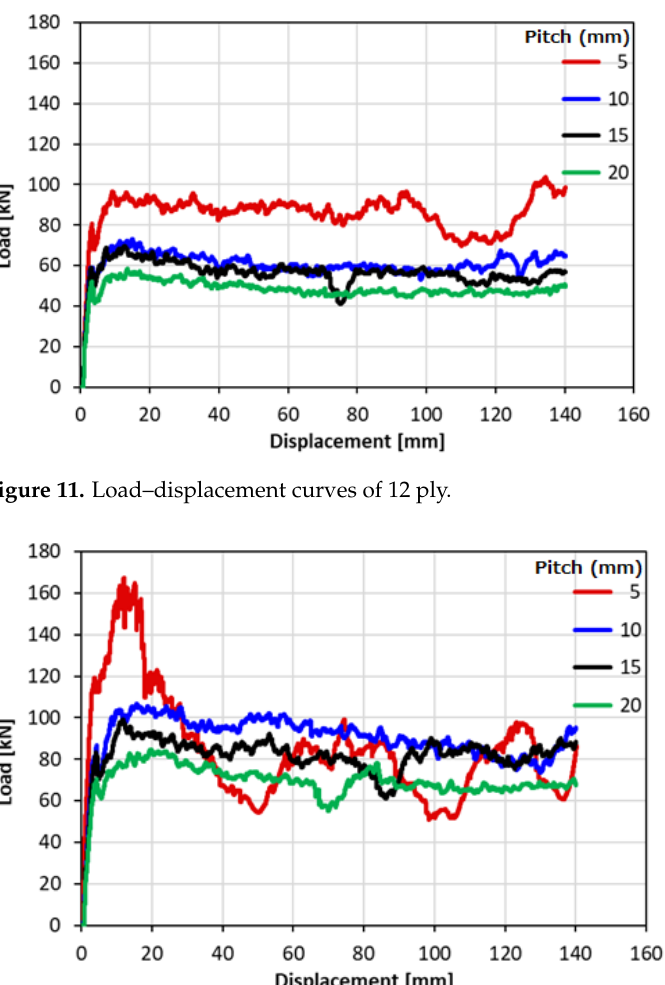
Figure 10. Load–displacement curves of 8 ply. Figure 10. Load – displacement curves of 8 ply. Figure 10. Load – displacement curves of 8 ply. Figure 10. Load – displacement curves of 8 ply.